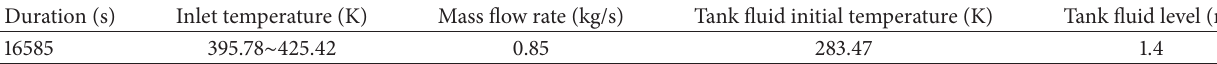
Table 4: Summary of test conditions.